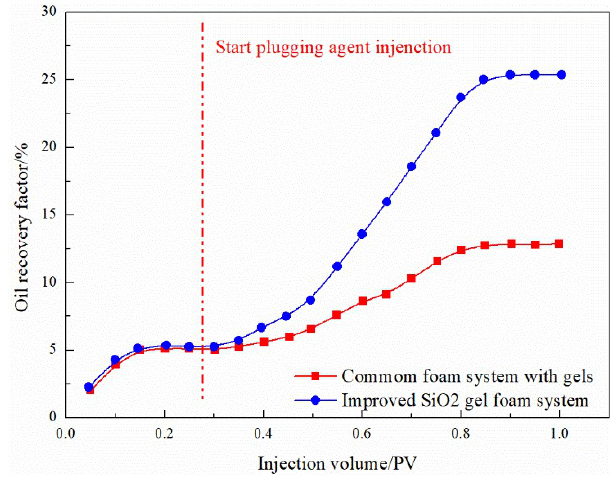
Figure 15. EOR experiment in the split core model.